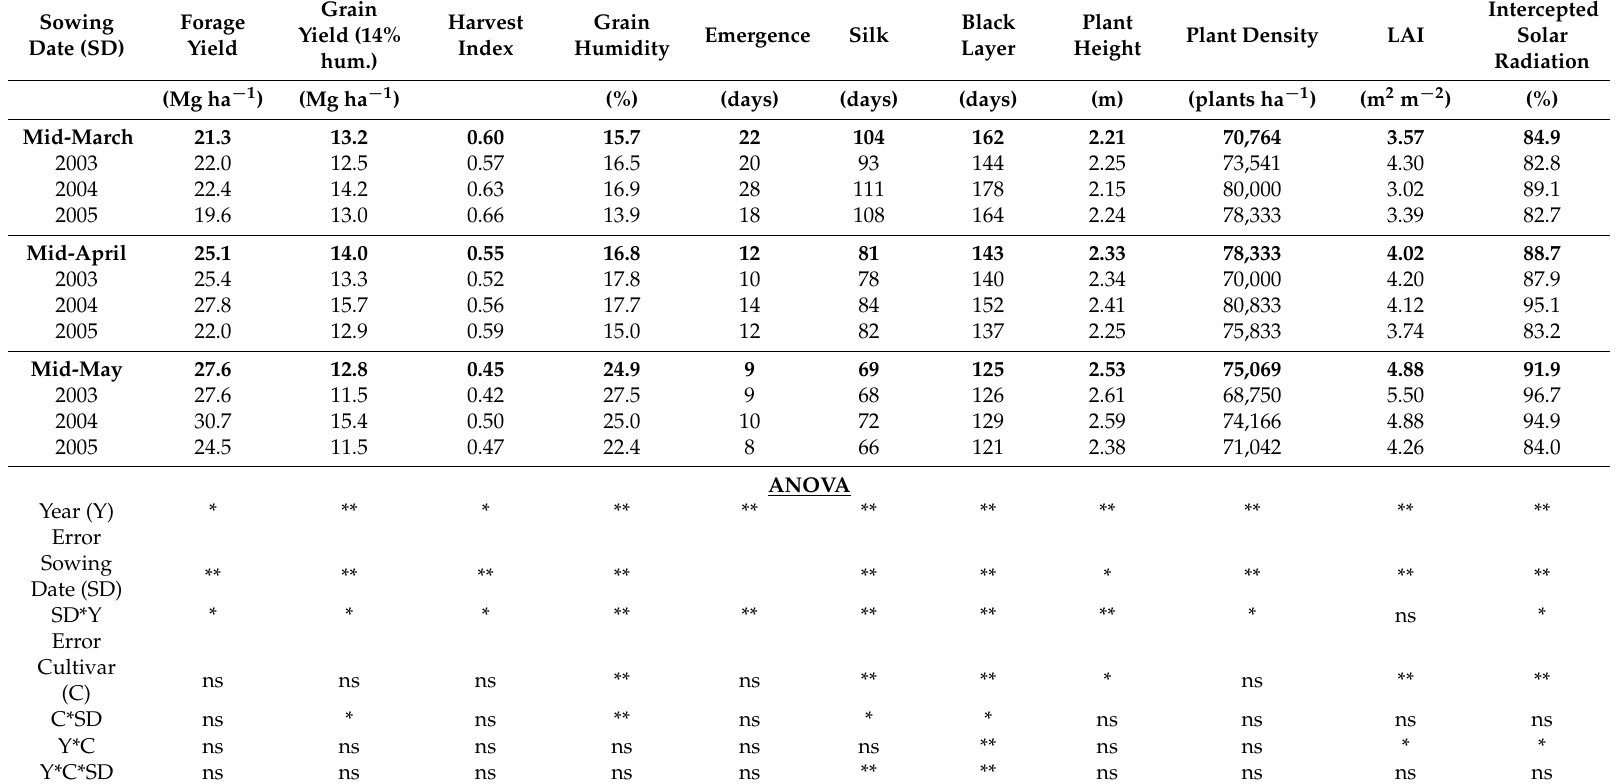
Table 4. Sowing date (SD) (mid-March, mid-April, and mid-May) effect on average forage maize dry matter (DM) yield at maturity, grain yield and humidity, the dates of emergence, silk and black layer appearance, and the days happened between sowing and silk and black layer appearance, plant height, leaf area index (LAI) and intercepted solar radiation (measured one week after silking). Average